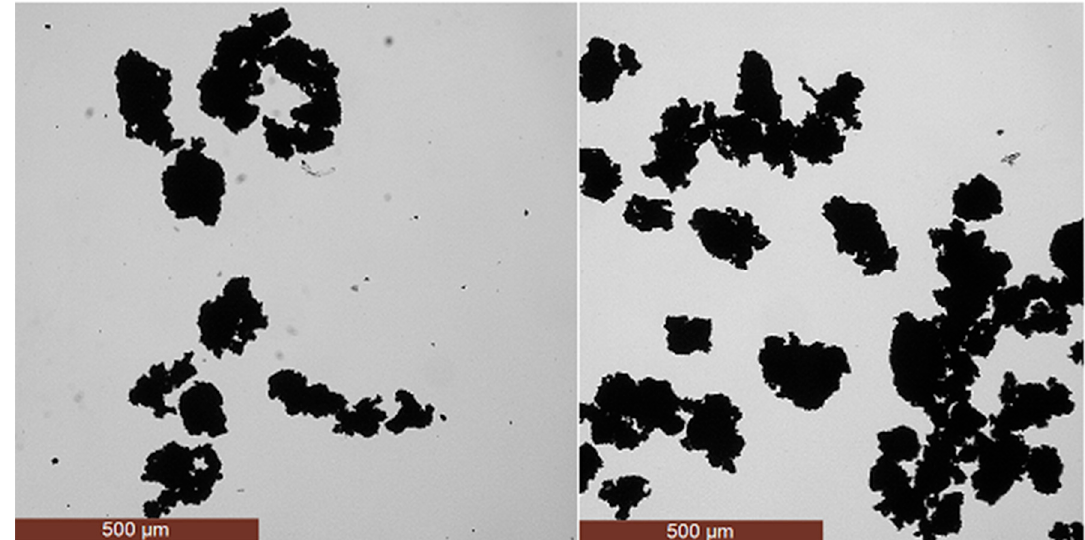
Figure 2. Optical micrographs of samples analyzed at different times, M1 at 10 s ( left ) and M9 at 2 min ( right ).